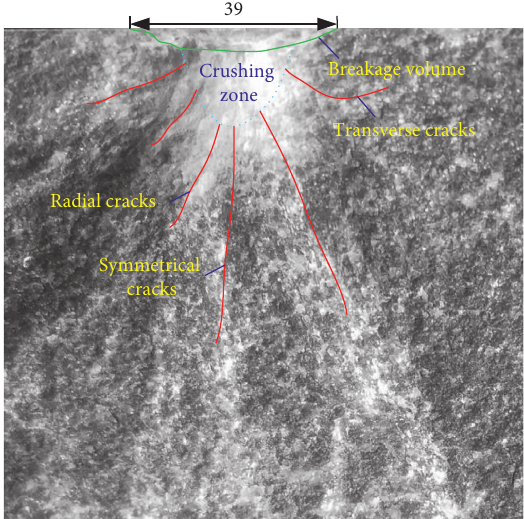
Figure 7: Crushing zone and crack distribution of the experimental rock breakage.